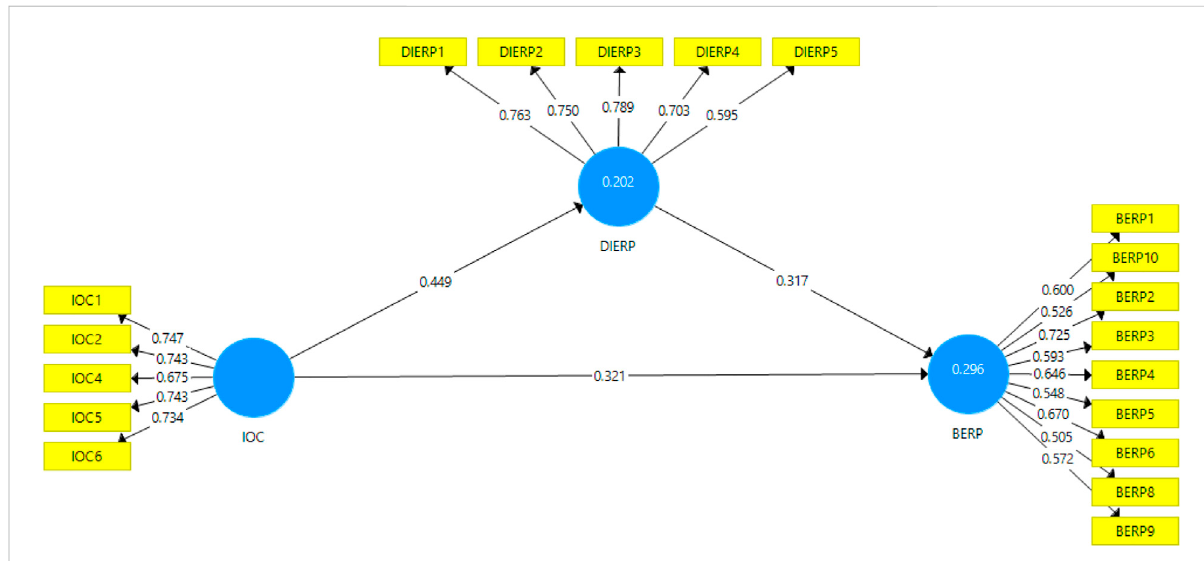
FIGURE 2 Mediating role of DIERP in the relationship between IOC and